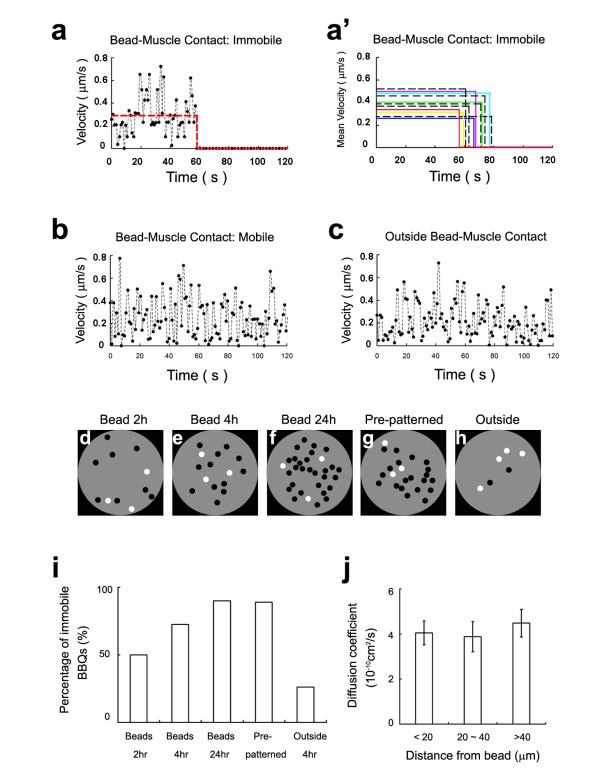
AChR movement during the formation of bead-induced clusters. (a-c) Instantaneous velocity plots of single BBQs at or away from a bead-induced AChR cluster. (a) Movement of a receptor at bead-muscle contact and its trapping at the 60 sec. The red line shows the mean velocity before and after trapping. (a') Additional examples of BBQ trapping. Only mean velocities of individual BBQs are shown. Color solid lines: BBQs underneath beads; black dashed lines: BBQs at the rim of beads. (b) Example of a freely moving BBQ at bead-muscle contact. (c) A freely moving receptor outside bead contact. (d-f) Schematic representation of immobile (black dots) and mobile (white dots) BBQs at a single bead-induced AChR cluster at 2, 4 and 24 hr after bead addition, showing increasing number of immobile receptors. (g) Immobility of BBQs at a pre-patterned cluster, in contrast to mobile ones outside the cluster area (h). (i) Quantification of receptor mobility based on diffusion coefficient measurements. Receptors with D less than 10-11 cm2/s are designated immobile and those with D above this value are considered mobile. BBQs outside bead-muscle contact were also tracked 4 hr after bead addition ("outside 4 hr"). (j) Diffusion coefficients of mobile BBQs at various distance away from bead-muscle contacts (mean ± sem; number of tracks analyzed: 19, 11 and 21 from near to far).